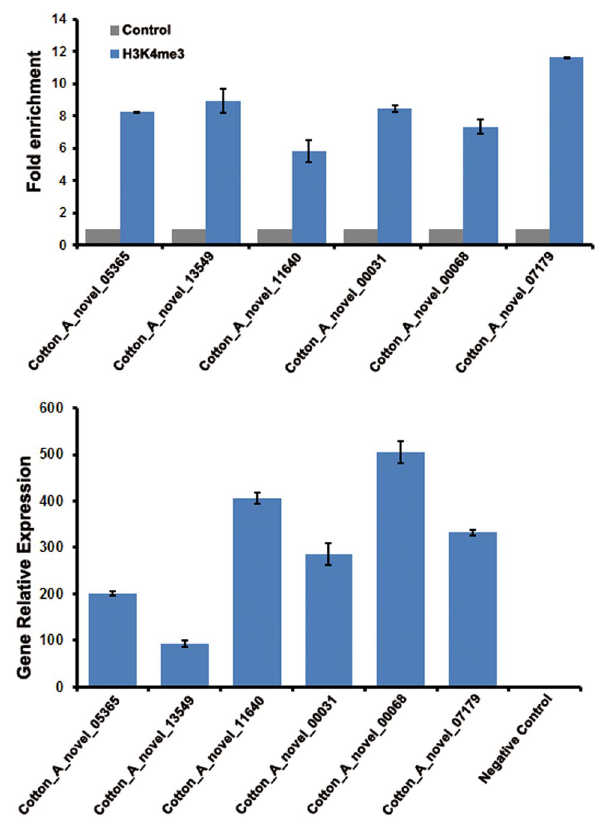
Figure 6. Results of qRT-PCR validation. The qRT-PCR confirming results of six selected novel transcripts which were Cotton_A_novel_05365, Cotton_A_novel_13549, Cotton_A_novel_11640, Cotton_A_ novel_00031, Cotton_A_novel_00068 and